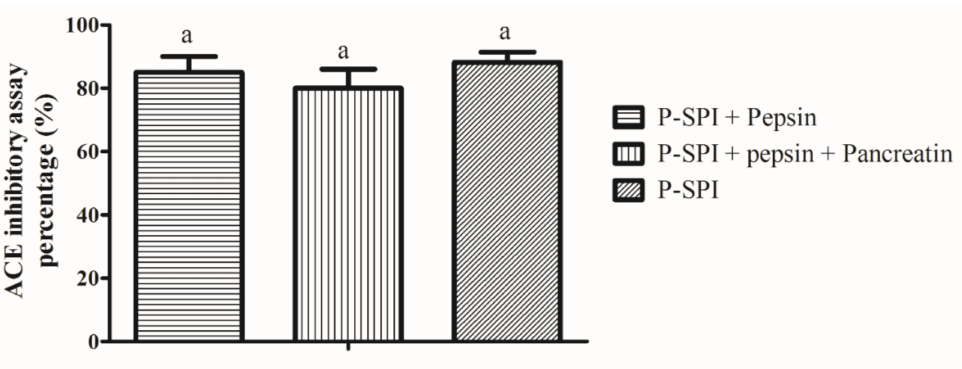
Figure 3. The effects of gastrointestinal enzymes on ACE inhibitory activity. Bars represent means of three replicates ( n = 3) ± SD, a p < 0.05.